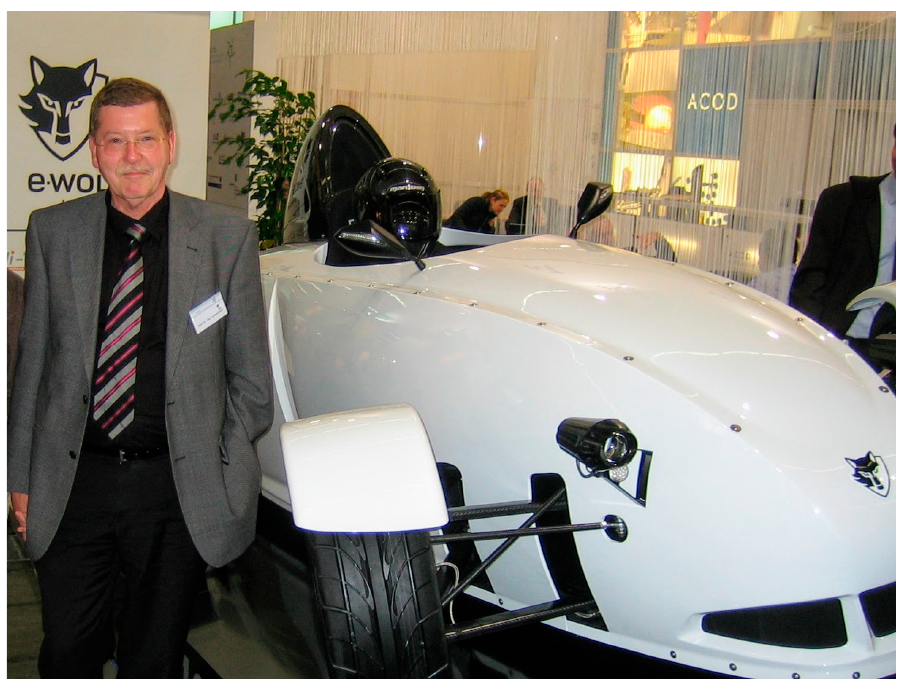
Figure 2. Walter Lachenmeier with his e-Wolf E1 electrical car exhibit at the 2009 IAA—International Automobile Exhibition, Frankfurt am Main, Germany (photo taken by the author).